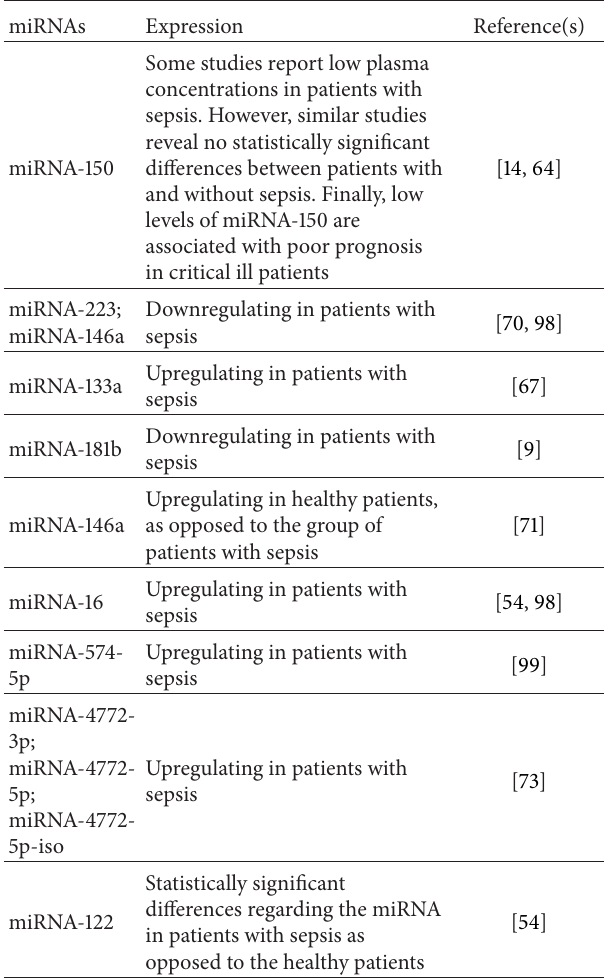
Table 2: miRNAs expression in